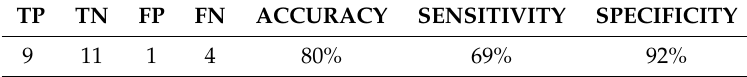
Table 5. Summary test results about the capacity of this algorithm to discriminate healthy controls from LBP patients. TP TN FP